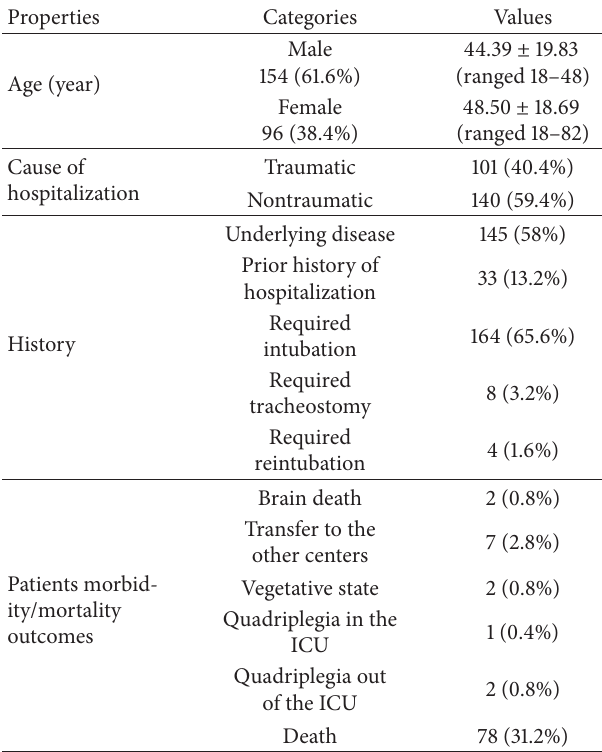
Table 1: Patients characteristics.